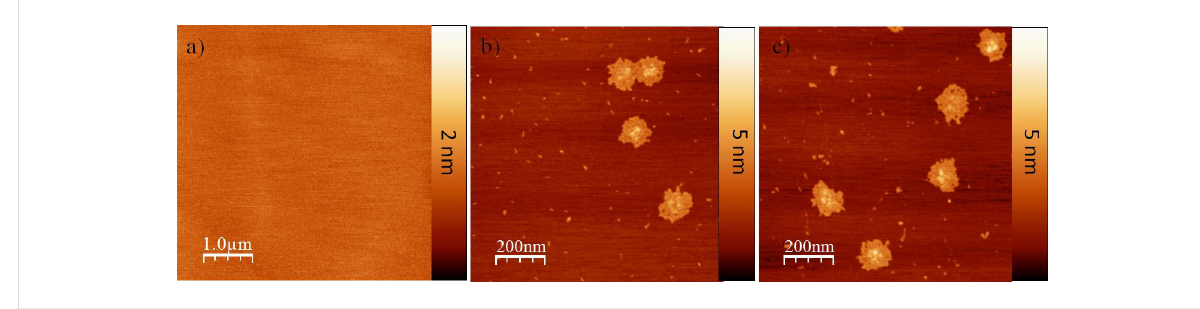
Figure 2: Representative AFM images of the pristine MoS 2 substrate before (a) and after the DNA origami solution was deposited onto it with different incubation times: 10 s (b) and 30 s (c).